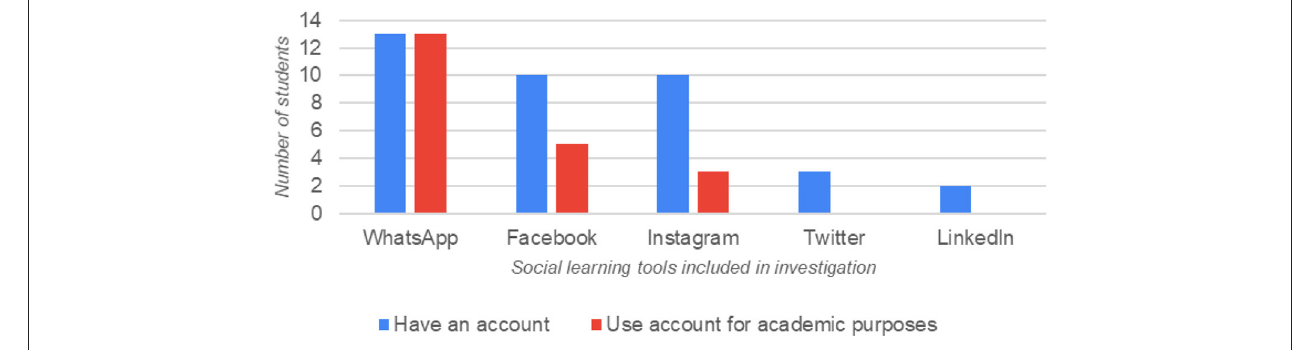
FIGURE 1 | Access to social learning tools and use thereof for academic purposes.